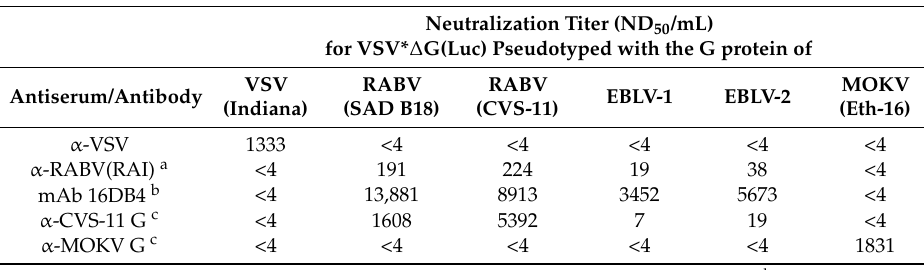
Table 1. Neutralization of pseudotype viruses by immune